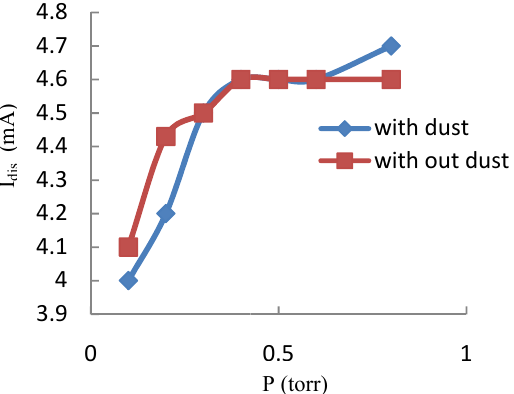
Fig.5: Va ariation of di